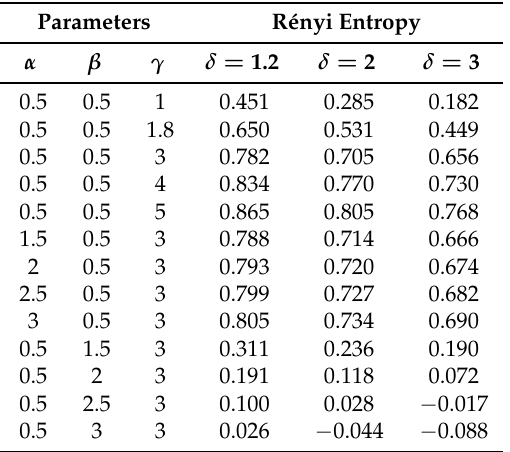
Table 4. Numerical values of the Rényi entropy of the EMIEE distribution at different values of α , β , and γ